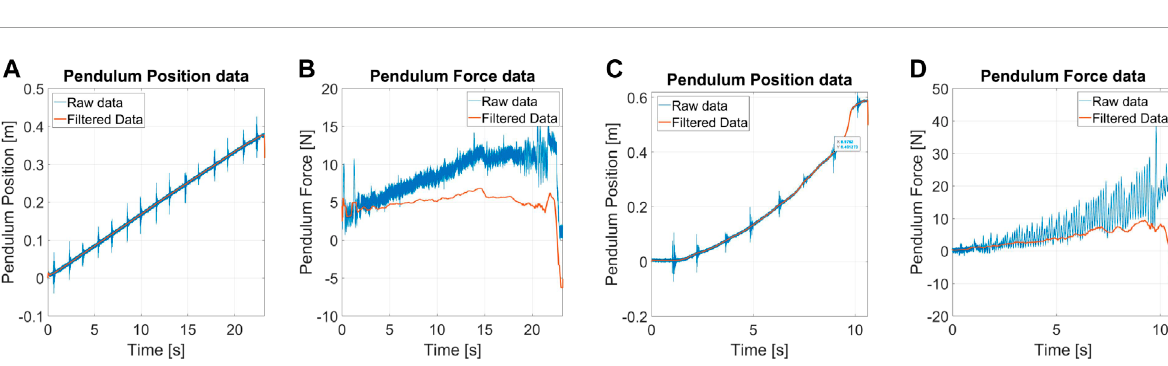
property, we also computed the damping ratio and the natural frequency, which are intrinsic properties instead ( Figure 10D